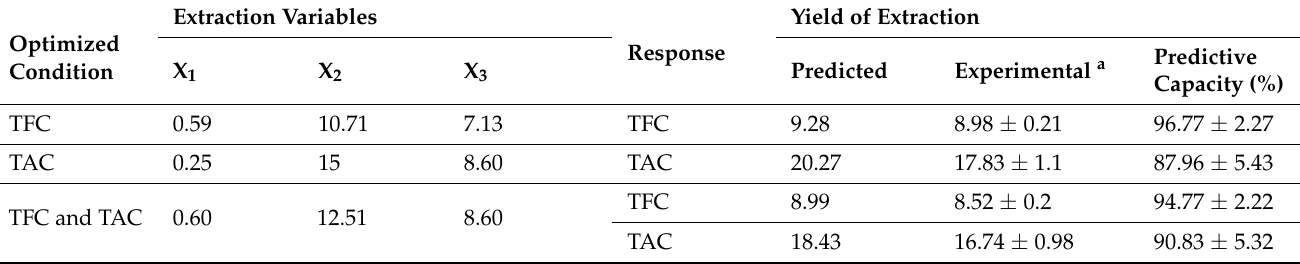
Table 6. Comparison between the experimental yields and predicted yields of total flavonoid content (TFC), total anthocyanin content (TAC), and the simultaneous extraction of both bioactive compounds (TFC and TAC) determined in the optimized